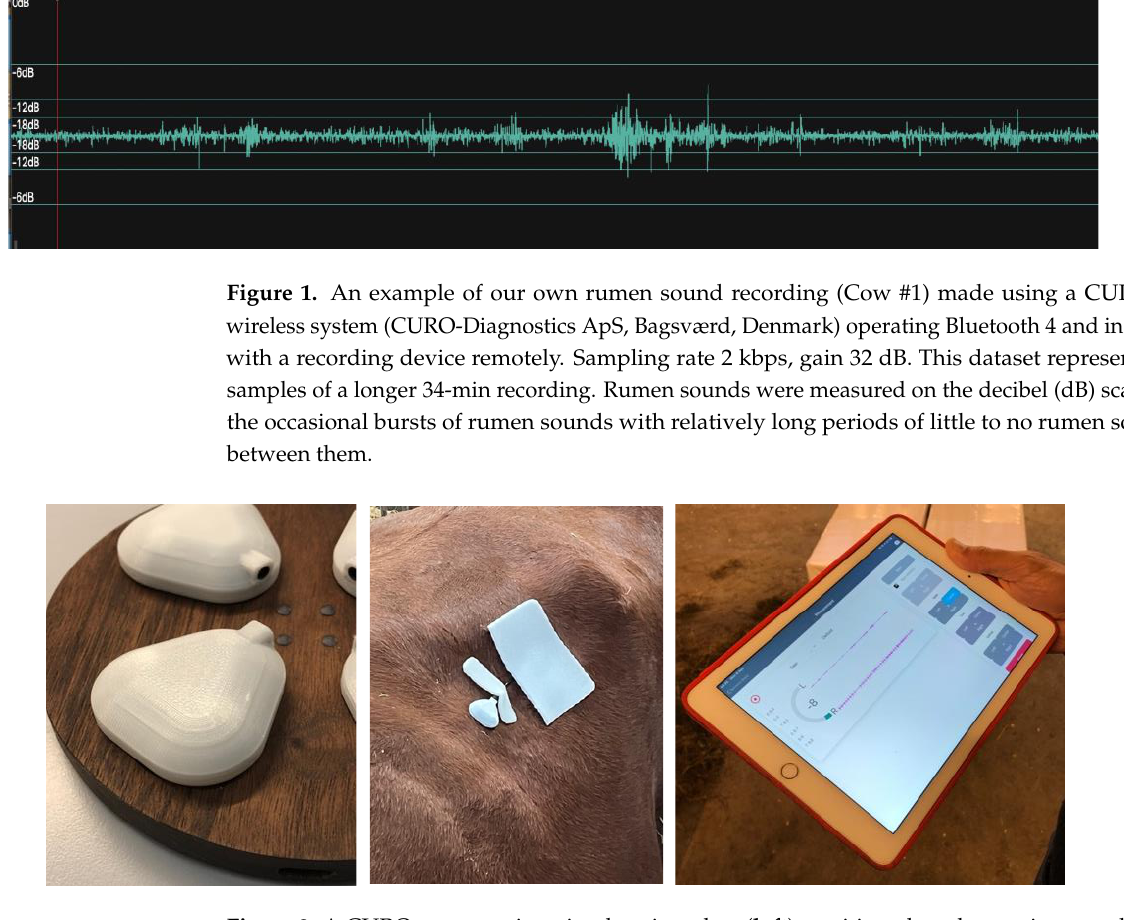
Figure 2. A CURO sensor unit on its charging plate ( left ), positioned on the ruminant at the site of interest ( middle ), generating recordings of rumen sounds in real time to an iPad ( right